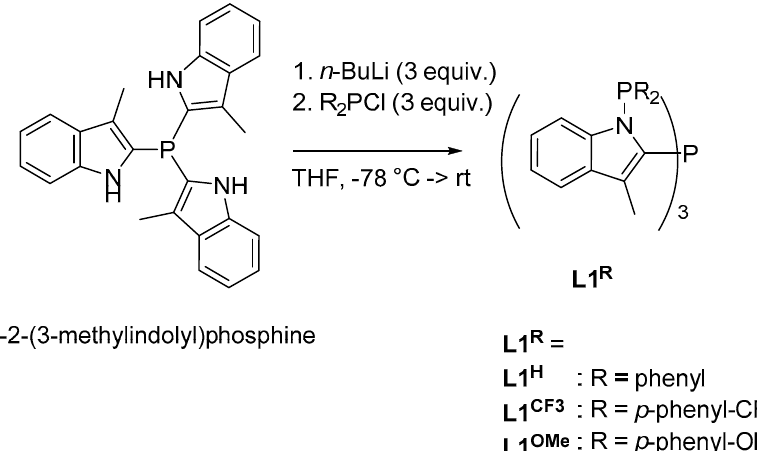
Figure 1. Synthesis of ligands L1 R by reacting tris-2-(3-methylindolyl)phosphine with the corresponding chlorodiarylphosphine.